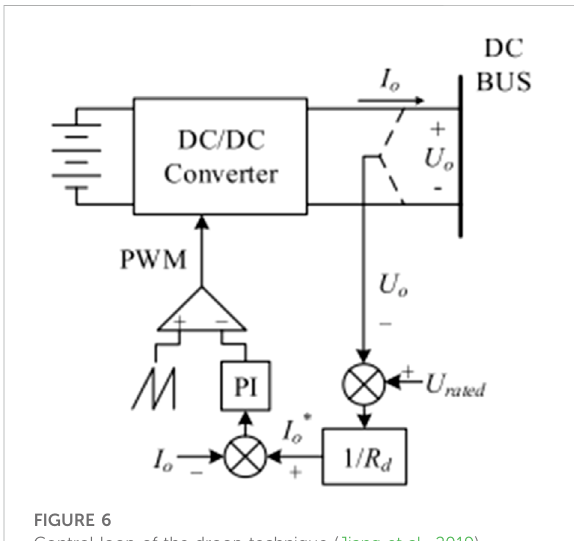
FIGURE 6 Control loop of the droop technique (Jiang et al.,